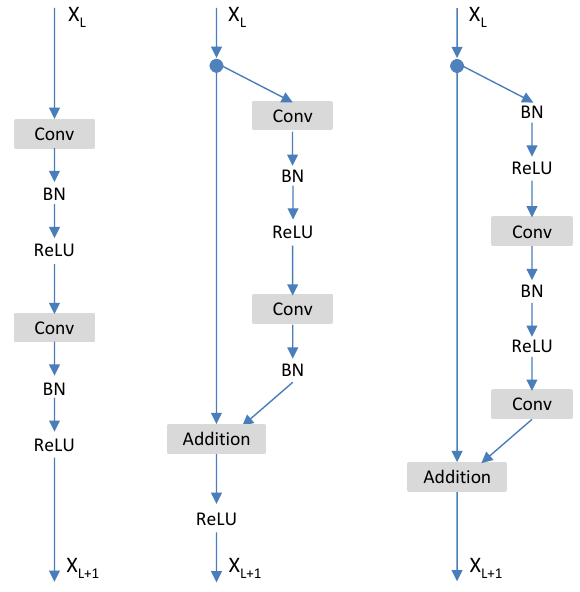
Three popular network connection styles: plain structure (left), original residual structure (center) and full pre- activation residual structure (right): the convolutional layers in residual structures are characterized by the number of filters n , the atrous rate r and the stride s (first convolutional layer: n , r , s ; second convolutional layer: n , r = 1 , s = 1